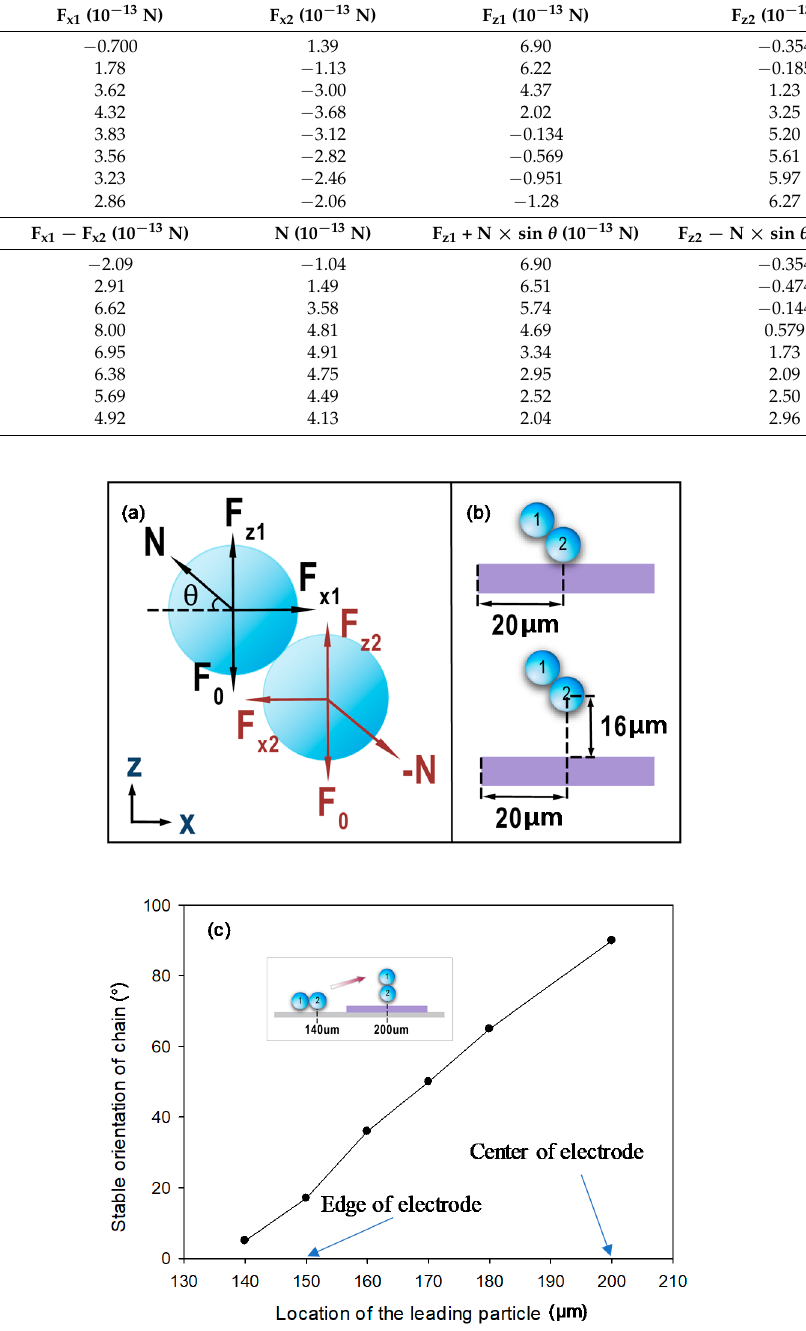
Figure 3. ( a ) A free-body diagram showing two particles in contact where F 0 equals the sum of gravitational force and buoyancy force, N is normal force, and θ is the angle. ( b ) A schematic showing two-particle chains at different height levels. ( c ) The stable angle formed by the particles with respect to the floor increases as the chain of particles moves from the gap region close to the edge of the electrode to the center of an electrode.